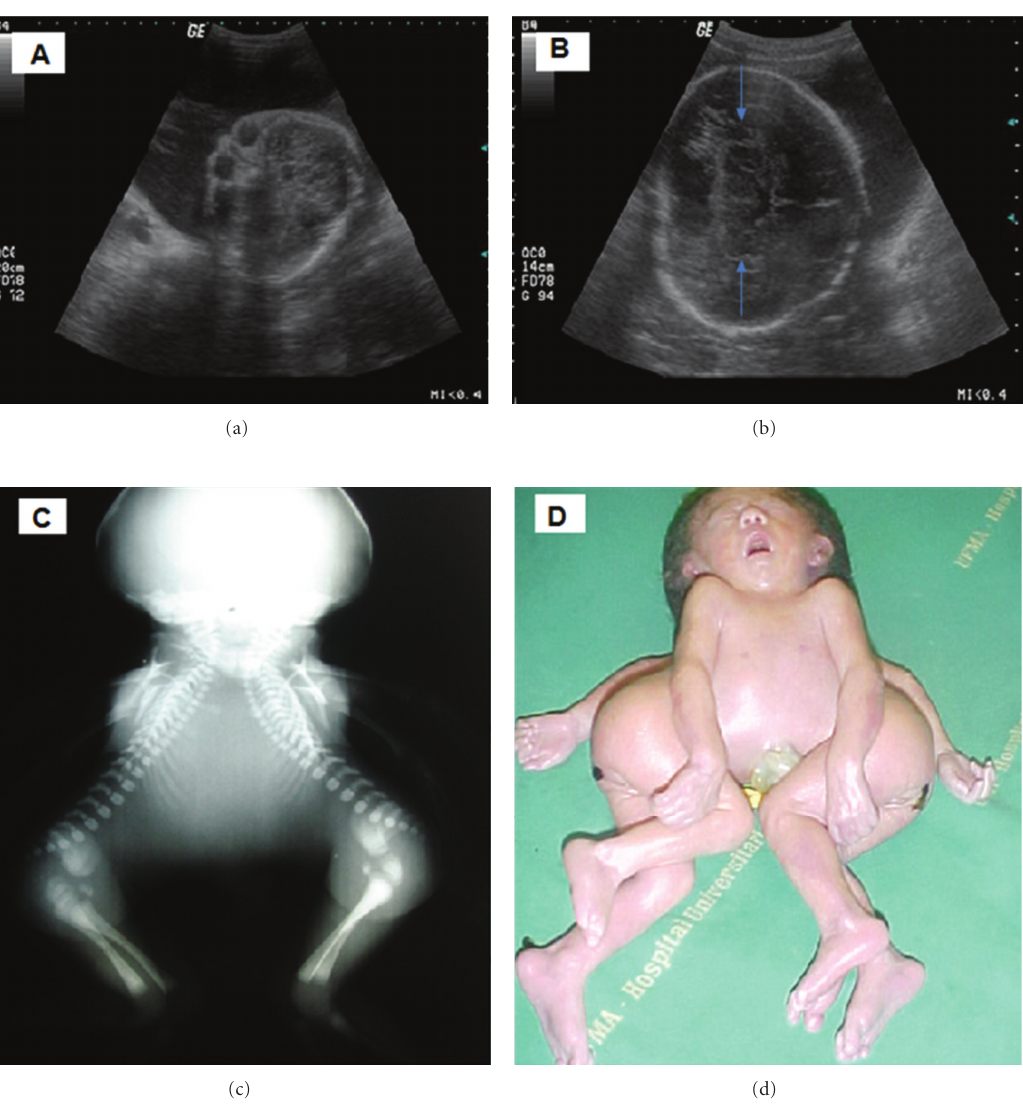
Figure 1: Cephalothoracopagus janiceps disymmetros. (a) Prenatal two-dimensional ultrasound showing only a skull with two faces and two eyes. (b) Prenatal two-dimensional ultrasound showing the brain with the thalamus fusion (blue arrows). (c) Postnatal X-ray showing the fusion of twins from head until upper abdomen. (d) Postnatal postmortem analysis confirming the prenatal